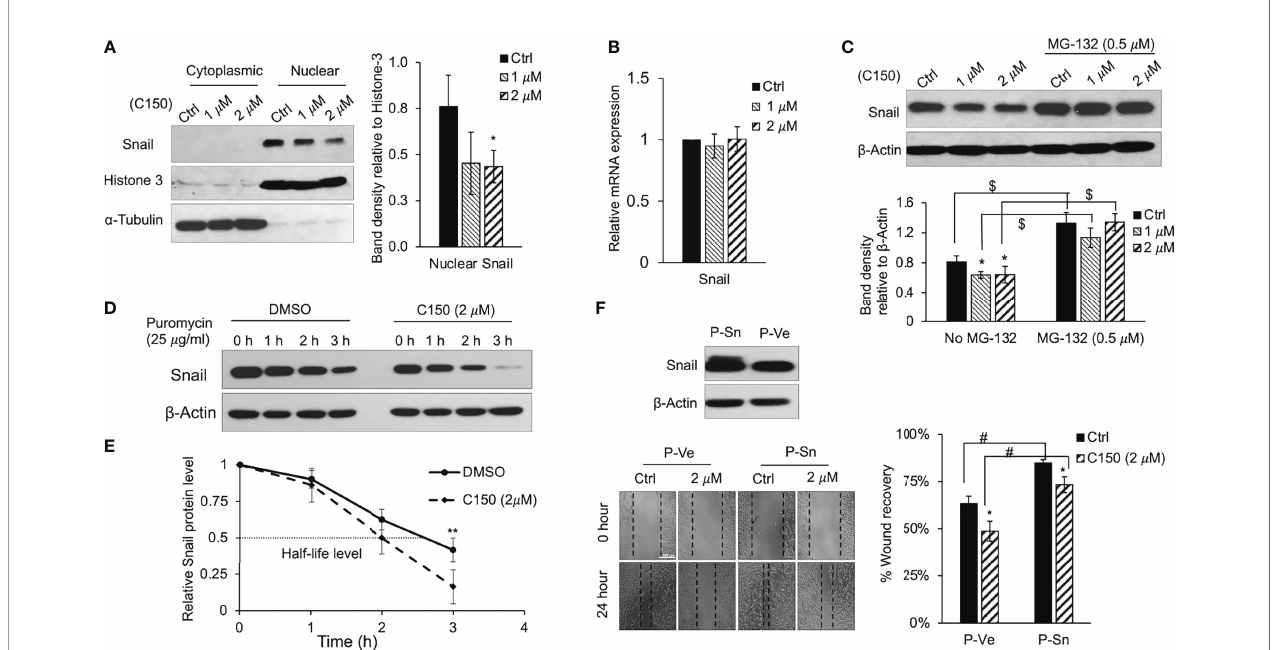
FIGURE 4 | C150 enhances Snail protein degradation. (A) Cytoplasmic and nuclear protein levels of Snail. PANC-1 cells were treated with DMSO (Ctrl) or C150 (1 and 2 m M) for 24 h. Cytoplasmic and nuclear fractional lysates were subjected to immunoblotting against Snail. Histone-3 and a -tubulin were blotted as nuclear and cytoplasmic loading controls, respectively. Bar graph shows the band density of nuclear Snail relative to Histone-3. (B) mRNA levels of Snail upon C150 treatment. PANC-1 cells were treated with DMSO (Ctrl) or C150 (1 and 2 m M) for 24 h. Reverse transcription-quantitative PCR results were quanti fi ed and normalized to the Ctrl group using the 2 - dd Cq method with GAPDH as the housekeeping gene. (C) Snail protein level upon C150 and MG-132 treatment. PANC- 1 cells were treated with C150 (1 and 2 m M) or co-treated with C150 and MG-132 (0.5 m M) for 16 h. Total lysates were subjected to immunoblotting against Snail. b -Actin was blotted as loading control. Bar graph shows the band densities of Snail relative to b -actin. (D) Snail protein levels post-puromycin treatment. PANC-1 cells were treated with DMSO or C150 (2 m M) for 24 h, then puromycin (25 m g/ml) was added to block protein synthesis. Cell lysates were collected at 0, 1, 2 or 3 h after puromycin was added. b -Actin was blotted as loading control. (E) Snail protein degradation curve. Snail band density relative to b -actin at indicated time points was quanti fi ed and normalized to that at 0 h in each group. (F) Wound healing assay in PANC-1 cells with Snail overexpression. PANC-1 cells were transfected with Snail plasmid (P-Sn) or empty vector plasmid (P-Ve) for 48 h. Overexpression of Snail was con fi rmed by western blotting. Transfected cells were then seeded for wound healing assay with DMSO (Ctrl) or C150 (2 m M) treatment for 24 h. Bar graph shows the percentage of wound recovery. Data are presented as mean ± SD of three to fi ve independent experiments. *P < 0.05, **P < 0.01 (vs. Ctrl); # P < 0.05 (P-Sn vs. P-Ve) by (A – C) one-way ANOVA followed by Tukey ’ s post hoc test or (E, F) Student ’ s t-test. $ P < 0.01 (non-MG-132 vs. MG-132) by Student ’ s t-test in (C) . C150, 2-[2-(5-nitro-2-thienyl)vinyl]quinoline; Ctrl,